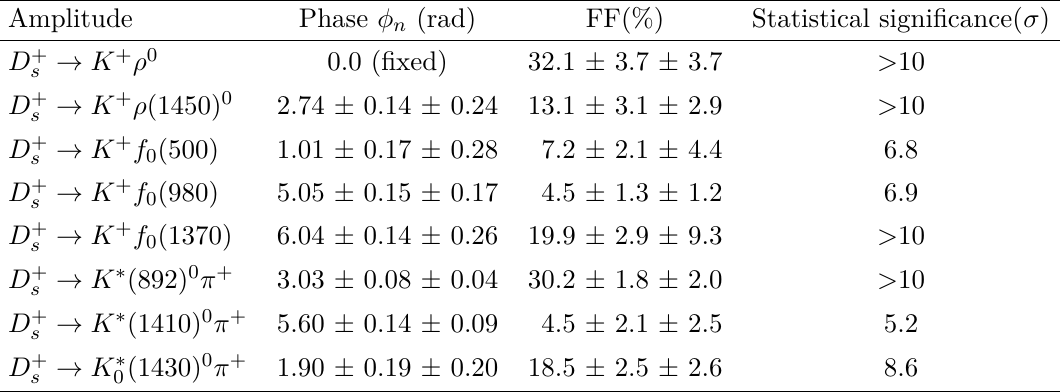
Table 5 . The phases, FFs and statistical significances for various amplitudes in the nominal fit. The first and second uncertainties of the phases and FFs are statistical and systematic, respectively. The total FF is